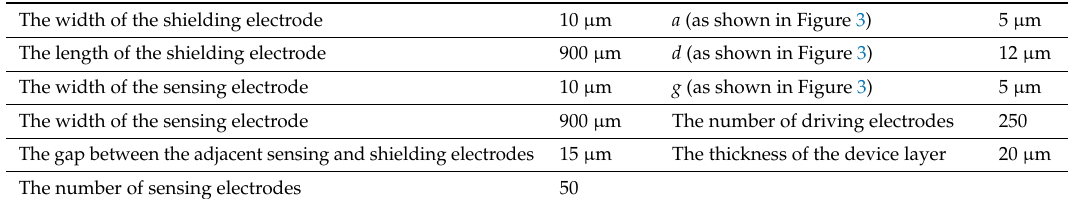
Table 2. The parameters of the EFS.